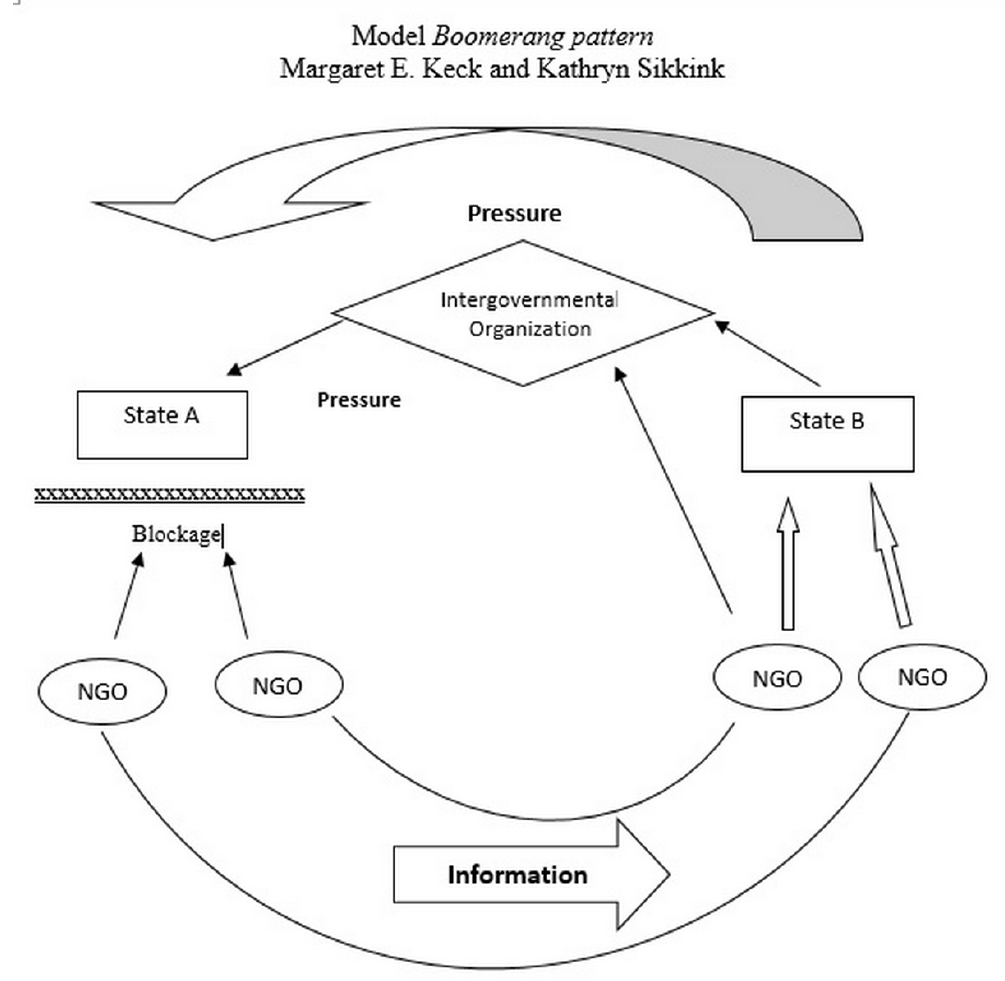
Figure 1. Boomerang pattern (boomerang effect): State A blocks redress to organizations within it; they activate the network, whose members pressure their states and (if relevant) a third-party organization, which in turn pressure State A